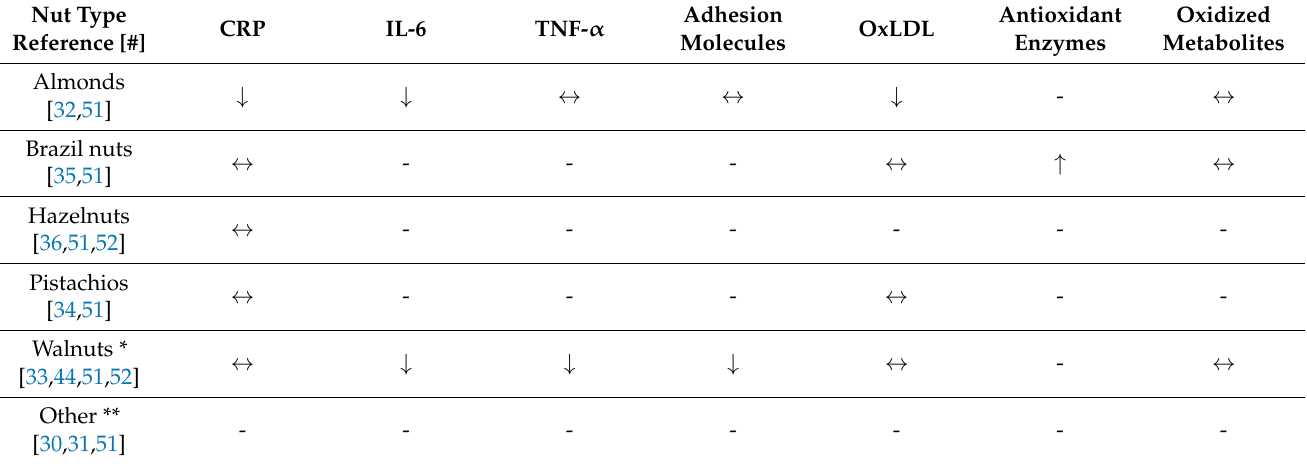
Table 2. Nuts and inflammation and oxidative stress biomarkers—current evidence from randomized controlled trials and research